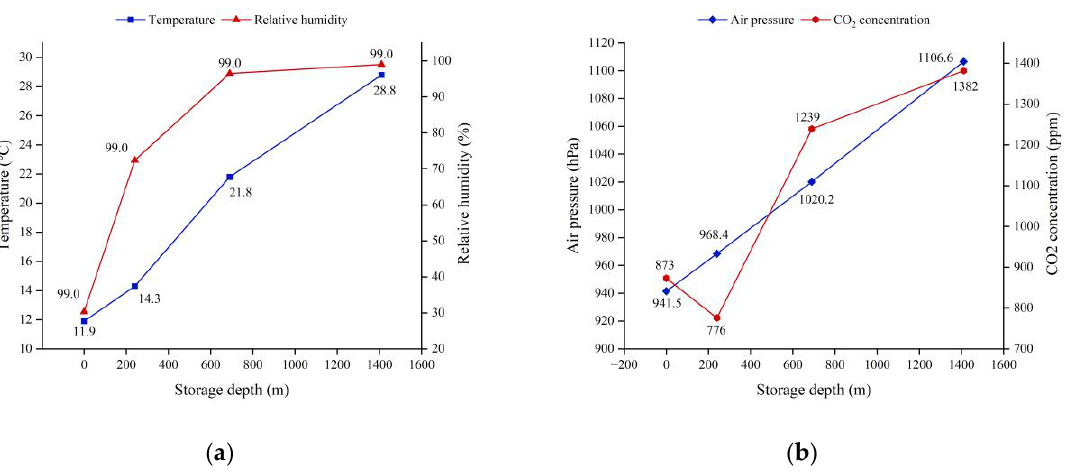
Figure 1. The relationship between environmental parameters and the storage depth. ( a ) Temperature and relative humidity with storage depth. ( b ) Air pressure and CO 2 concentration with storage depth. Adapted from Reference [4]. 2022, Springer Nature.